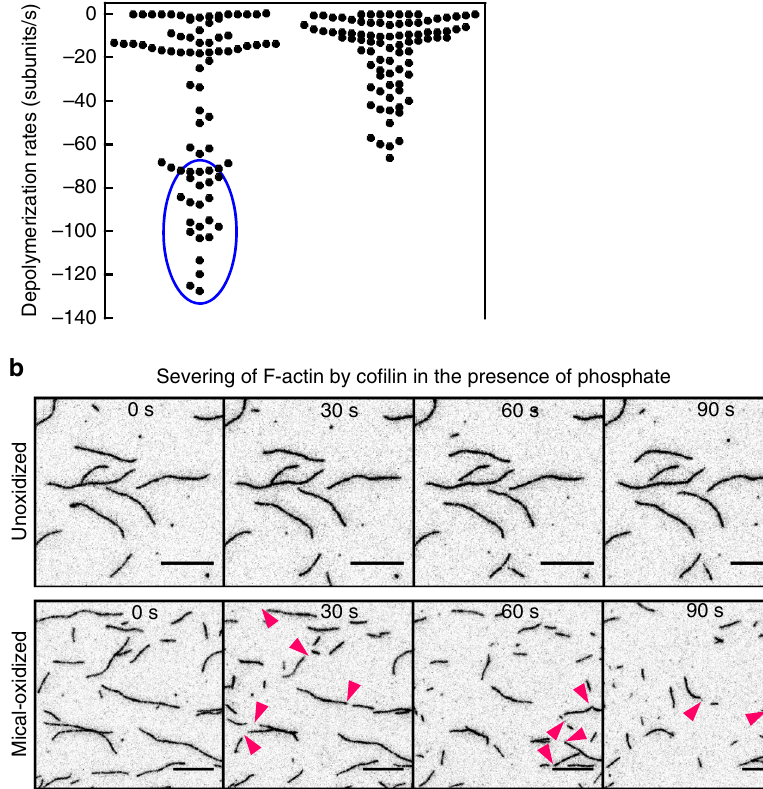
Fig. 3 Mical oxidation of both M44 and M47 residues on actin drives its catastrophic disassembly and co fi lin severing. a Mical oxidation of both — M44 and M47 — contributes to F-actin destabilization. Single fi lament depolymerization rates of 5C-WT and 5C-M47L 2 min after addition of Mical (10 nM) and NADPH (0.1 mM) into the fl ow chamber. Rates were determined from the TIRF movies ( n = 3 samples per condition). Two independent preps of each actin form (WT and M47L) were tested. Rates corresponding to the catastrophic disassembly events are encircled in blue. b Mox-F-actin in the presence of inorganic phosphate (Pi) (12.5 mM) is rapidly severed and disassembled by co fi lin. Co fi lin-induced actin disassembly is very slow in unoxidized actin (top panel) and no severing events were observed. Note, that co fi lin-mediated disassembly is extensive in ADP-Pi-Mox-F-actin (bottom panel) (also compare to the Supplementary Fig. 2a). Severing events are indicated by magenta arrowheads. Bar = 10 µ